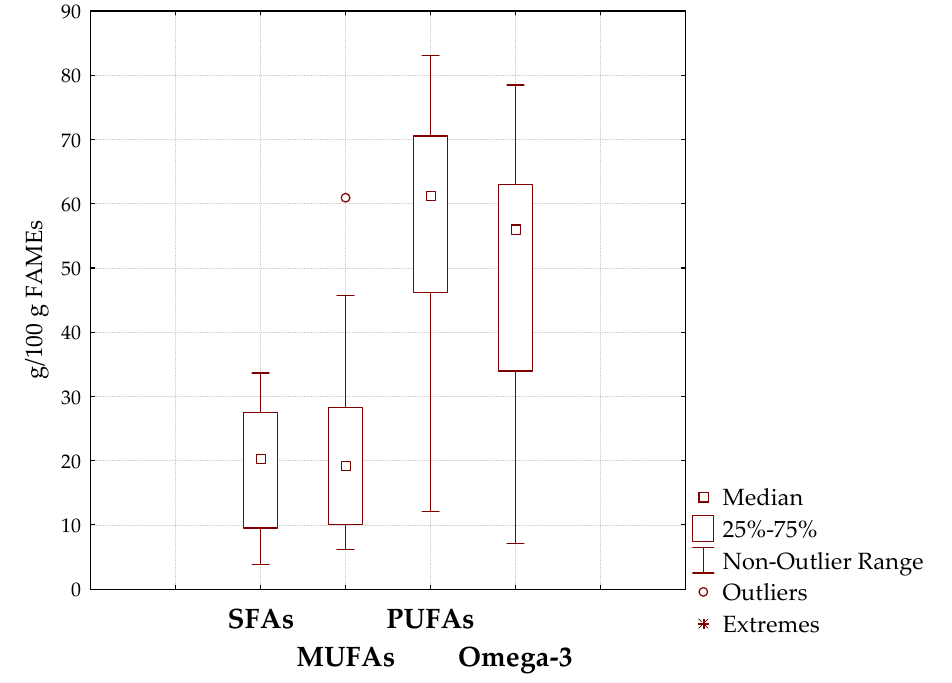
Figure 1. Total saturated (SFA), monounsaturated (MUFA), polyunsaturated (PUFA), and omega-3 fatty acid content in the analyzed supplements.